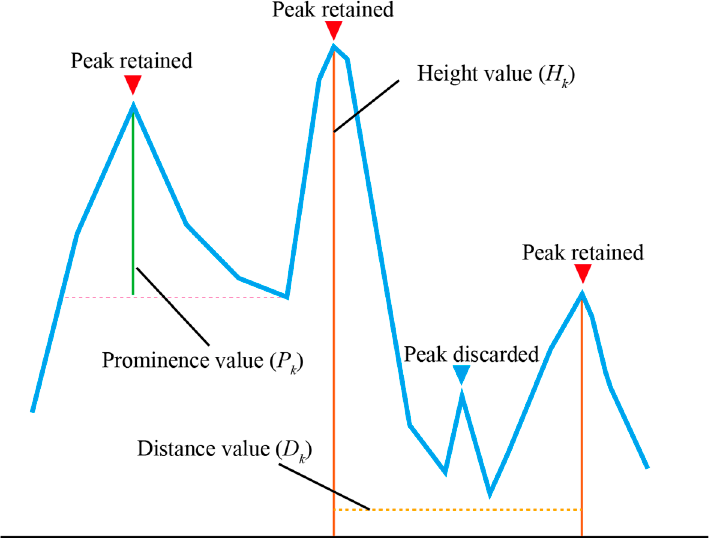
Figure 7. A diagram of the peak heights, prominence value, and distance value within the histogram.